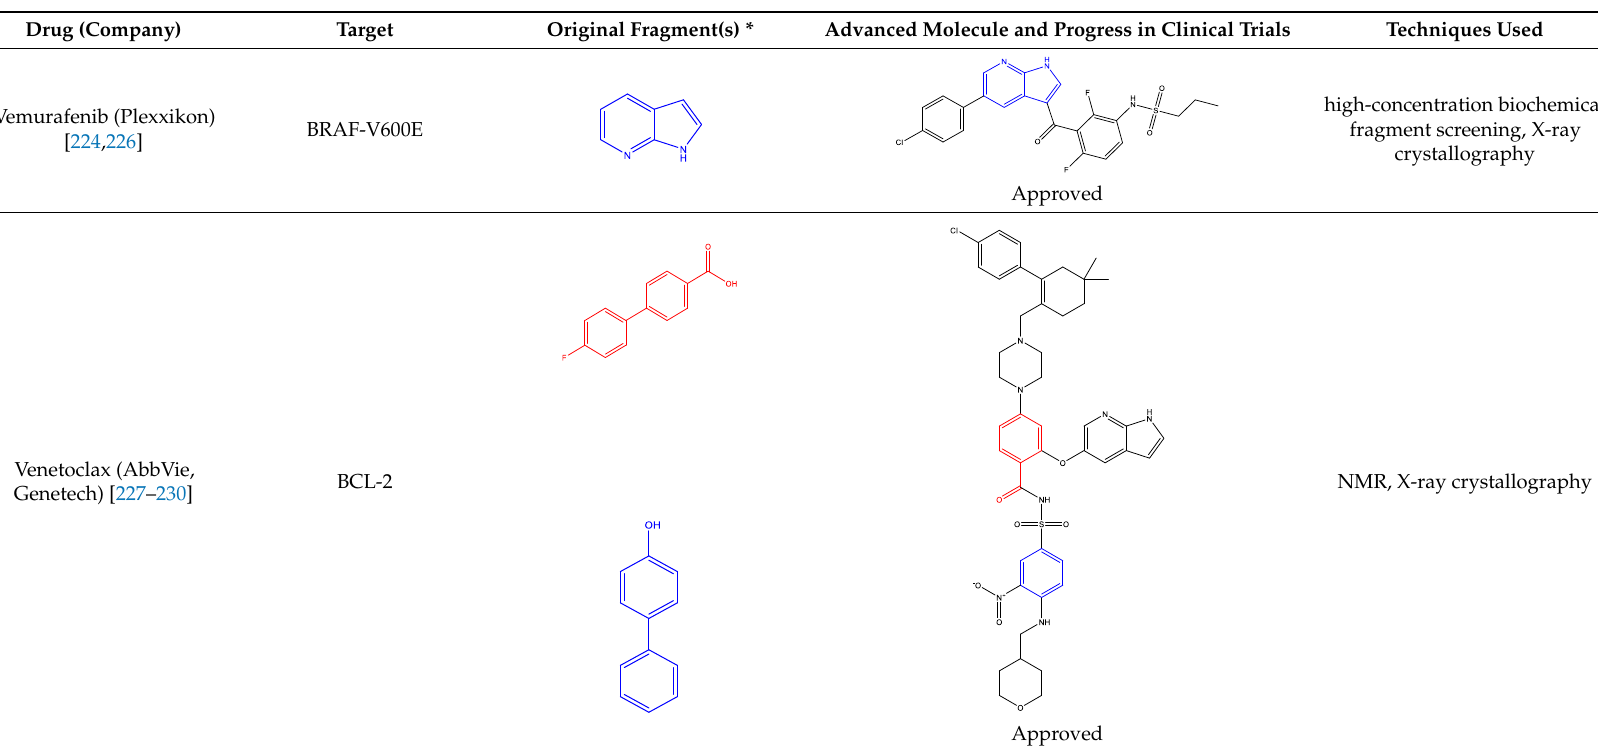
Table 2. The names, structures, targets, FBDD optimization strategy used, biophysical techniques used, and status in clinical trials of select drugs derived from the FBDD approach.